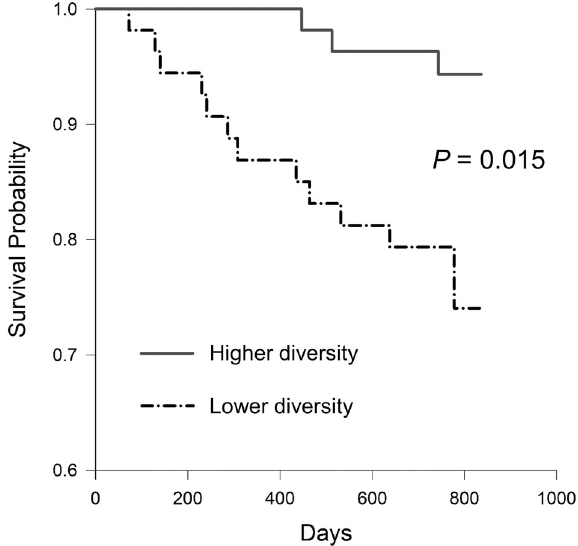
Fig. 2 Kaplan – Meier analysis curves. Hemodialysis patients were strati fi ed by the median of the Simpson index to assess the unadjusted risks for all-cause mortality. Prevotella enterotype (16.1% and 21.4% for survivors and nonsurvivors, respectively). Mean relative abundances of all genera in survivors versus nonsurvivors are shown in Supplemen- tary Table 2. α -Diversity analysis revealed signi fi cant differences between groups. Nonsurvivors had signi fi cantly lower values for the Simpson index ( P = 0.007) and the Shannon index ( P = 0.028) (Fig. 3). The difference in microbial composition ( β -diversity) between the two groups was insigni fi cant ( P = 0.482) (Supple-